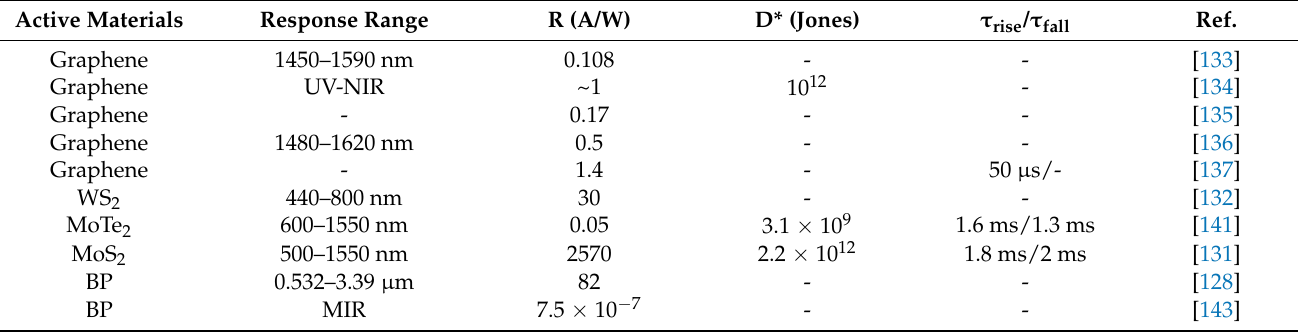
Table 2. Summarized device performance of photodetectors in Section